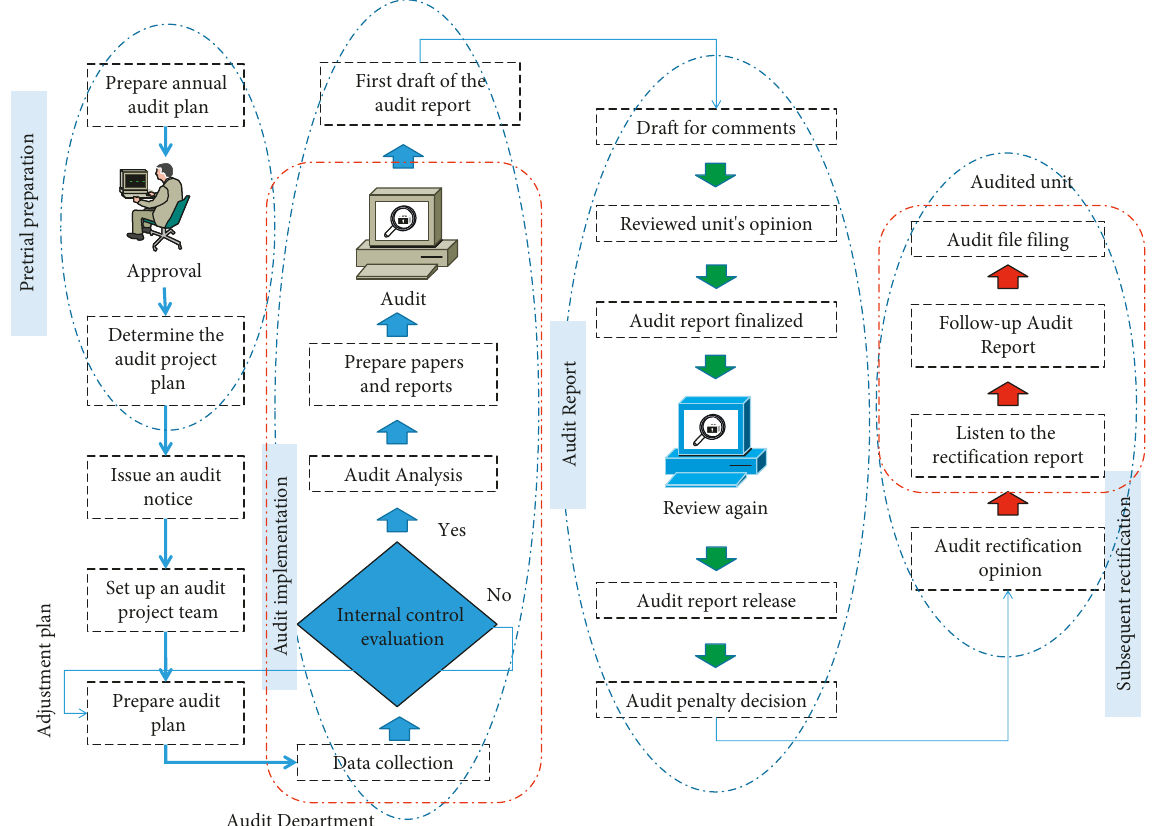
Figure 1: Audit business process